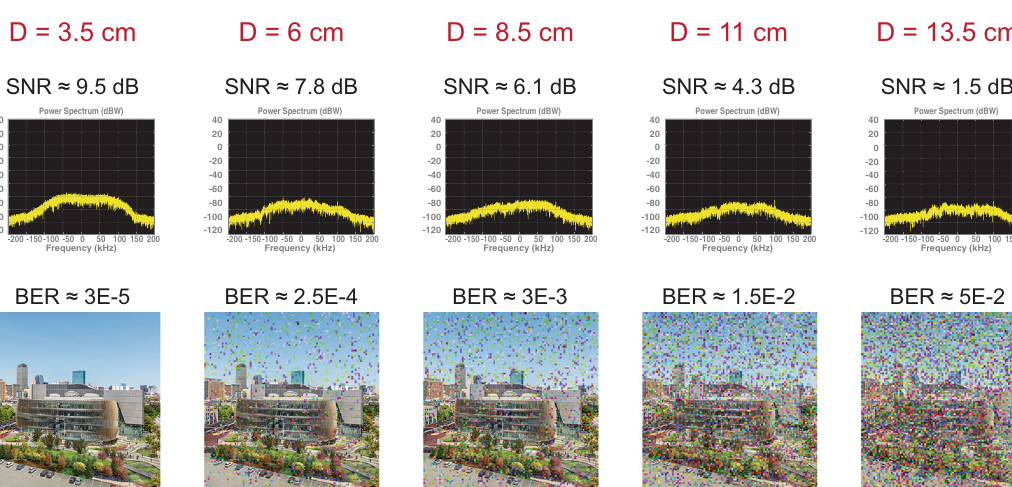
which corresponds to a large bandwidth BW − 6dB ≈ 401 kHz at a